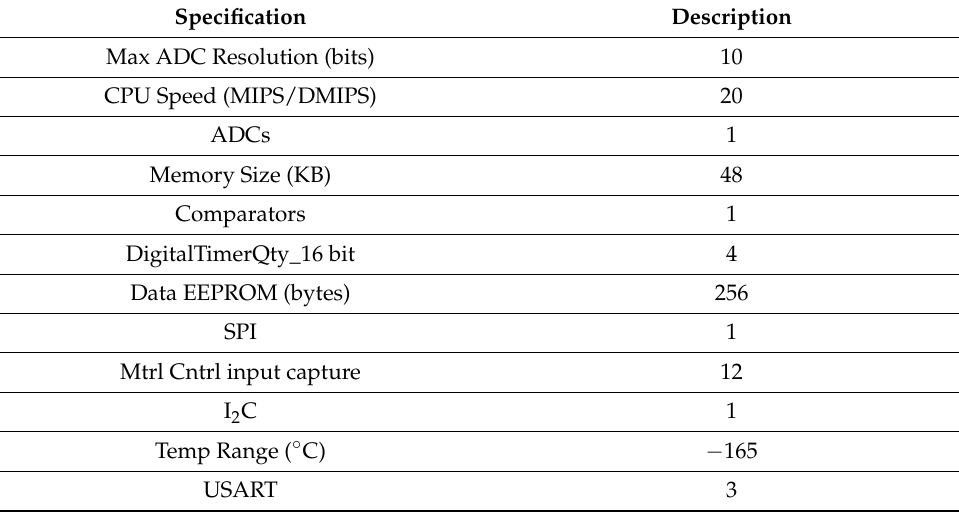
Table 5. ATMega-4808 specification. Adapted from Ref. [29].